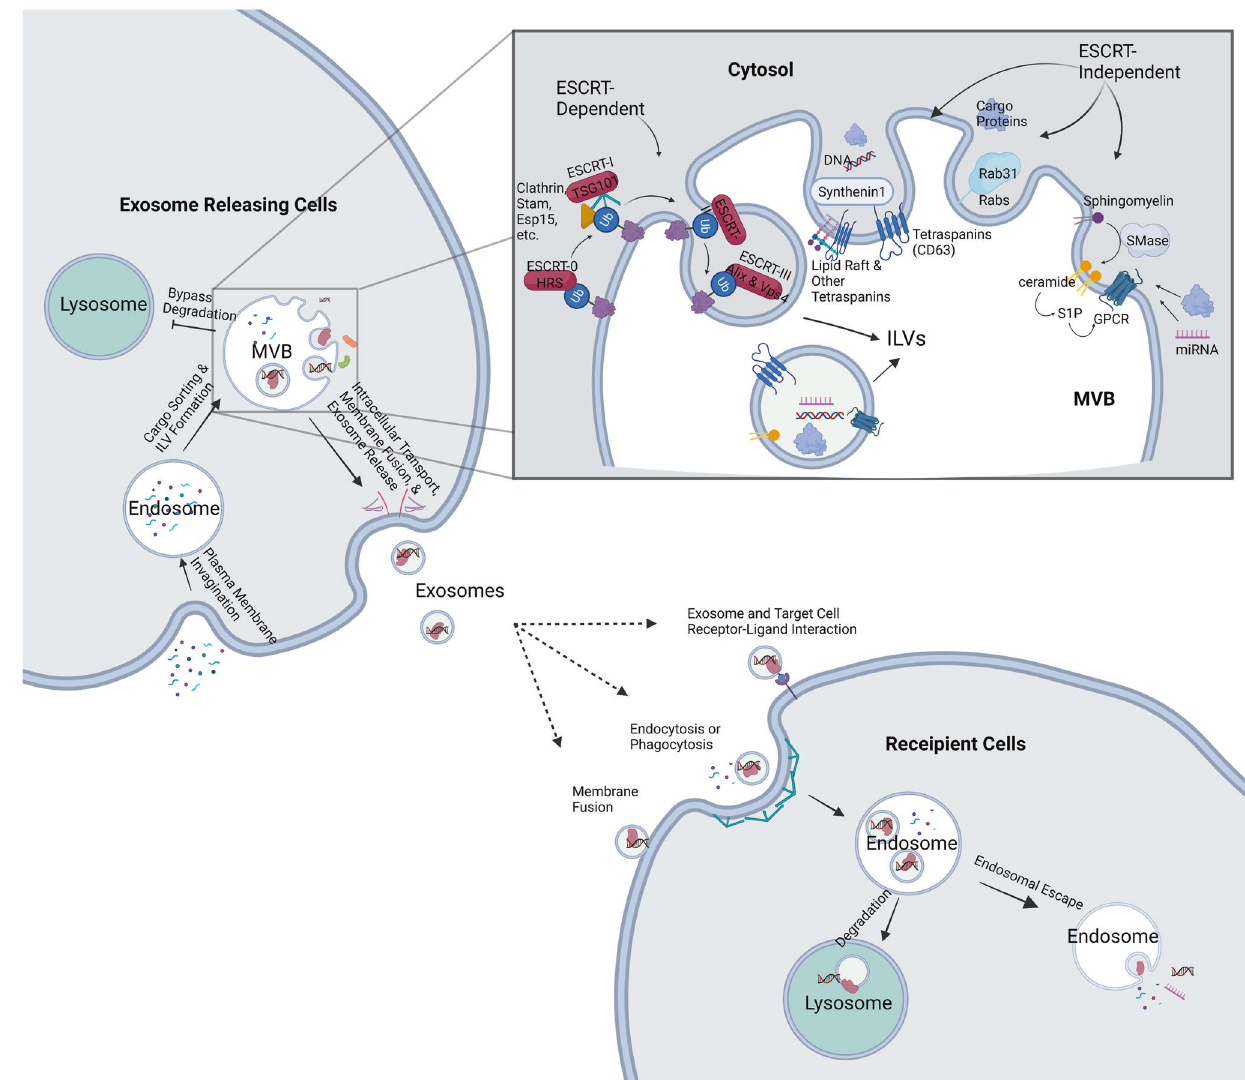
Fig. 1 Overview of exosome biosynthesis and uptake pathways. Intraluminal vesicles (ILVs) are synthesized from endosomes through cargo- sorting machineries and concurrent membrane invagination. The ILVs-containing multi-vesicle bodies (MVBs) then bypass lysosomal degradation and are transported to the plasma membrane, where they undergo vesicle docking, resulting in the release of exosomes into the extracellular space. Exosomes interact with the recipient cells by receptor-ligand interaction, membrane fusion, or phagocytosis or endocytosis. Being phagocytosed or endocytosed, exosomes bypass endosome-lysosome pathway and release their contents in the cytoplasm. Four exosomal protein sorting machineries (ESCRT-, tetraspanins-, Rabs-, and ceramide- dependent machineries) are depicted in the zoom-in